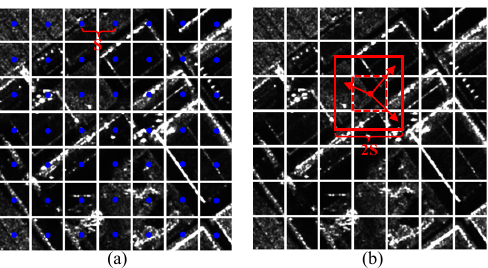
Figure 4. SLIC program diagram. ( a ) Initialization of the cluster centers. ( b ) Pixel–superpixel assignment.